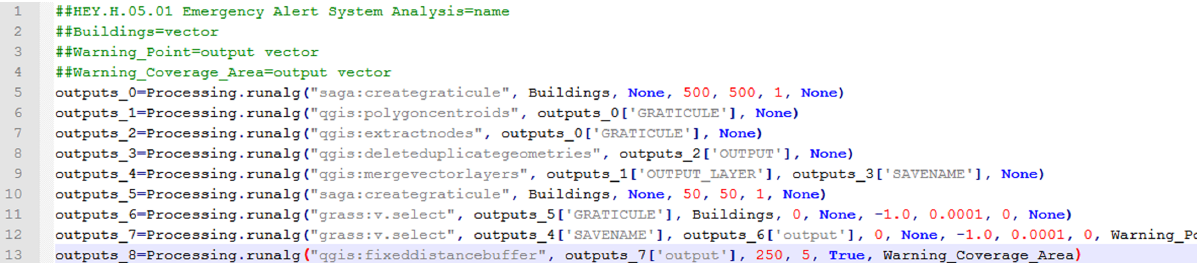
satellite imaging determines vegetation as land cover object ( “featuretype” AraziOrtusuNesnesi